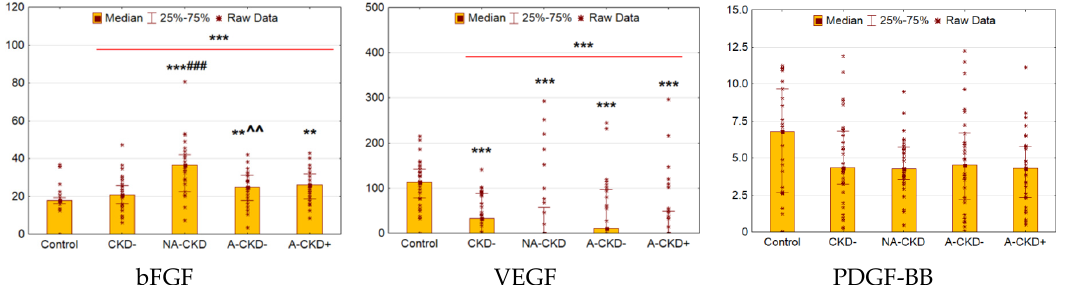
Figure 7. Serum concentrations of growth factors: bFGF(pg/mL), VEGF (pg/mL), and PDGF-BB (ng/mL). CKD − : The group of individuals with estimated glomerular filtration rate(eGFR) ≥ 60 mL/min/1.73 m 2 and urinary albumin-to-creatinine ratio (UACR) <3.0 mg/mmol; NA-CKD: Non-albuminuric chronic kidney disease, the group of individuals with eGFR <60 mL/min/1.73 m 2 and UACR <3.0 mg/mmol; A-CKD − : Group of patients with eGFR ≥ 60 mL/min/1.73 m 2 and UACR ≥ 3.0 mg/mmol; A-CKD+: Group of individuals with eGFR <60 mL/min/1.73 m 2 and UACR ≥ 3.0 mg/mmol. ** p < 0.01, *** p < 0.001 vs. control, ### p < 0.001 vs. CKD − , ^^ p < 0.01 vs. NA-CKD; Mann–Whitney and Kruskal–Wallis